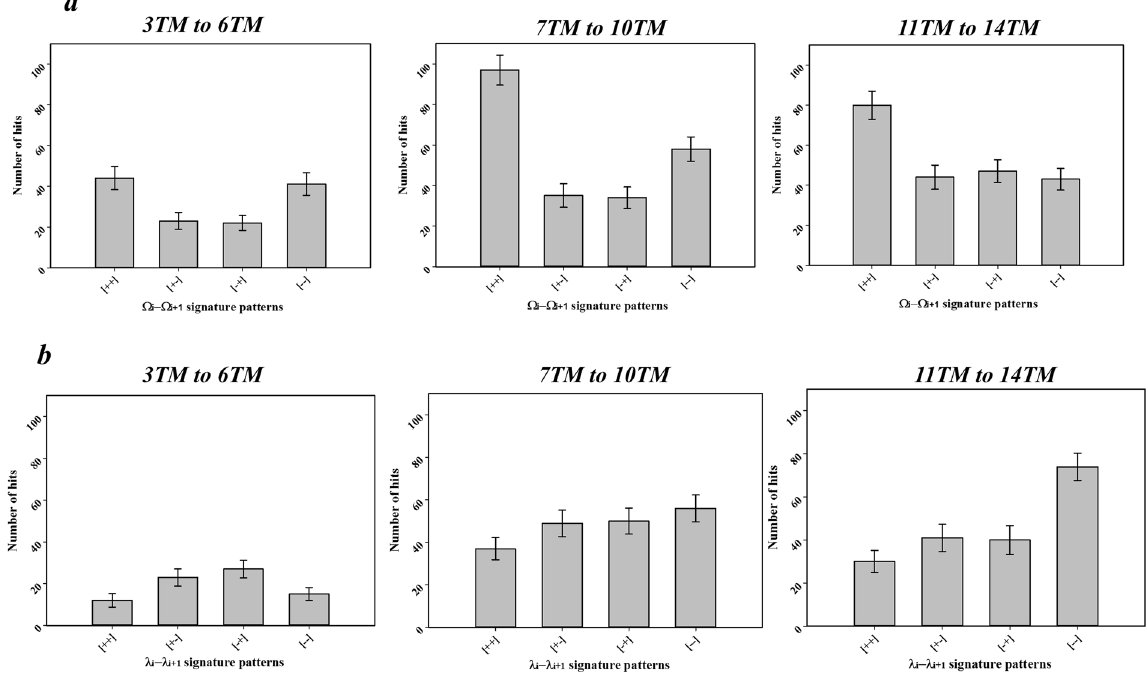
Figure 8. Frequencies of the patterns for two consecutive Ω or λ type dihedral angles depending on the proteins with a different number of TM helices. The 103 non-homologous proteins were categorized into three groups, i.e., proteins with 3 to 6 TM helices, 7 to 10 TM helices, and 11 to 14 TM helices. The bar diagrams show the observed numbers of ( a ) four different patterns of two consecutive Ω type angles, Ω i -Ω i + 1 , in each group, and ( b ) four different patterns of two consecutive λ type angles, λ i - λ i + 1 , in each group. Here, like ( a ) and ( b ) in the Fig. 5, (i) Ω or λ type angles were split into two regions, i.e. ( + ) = 0° to 180°, ( − ) = 0° to − 180°, (ii) four patterns were generated from the combinations of two consecutive angles, and iii) finally, the number of the patterns in the three groups were measured. Error bars are generated by bootstrapping represent standard deviation, resampling the data 500 times with replacement and repeating the analysis 44